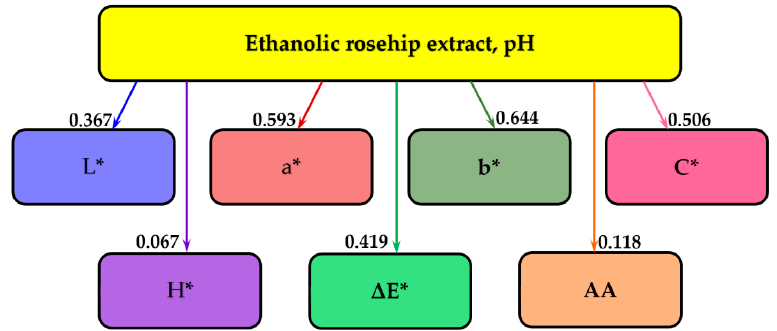
Figure 4. The influence of the pH on the CIELab color parameters and antioxidant parameters of rose hip extract. L*—luminosity; a*—red / green component; b*—yellow / blue component; C*—chromaticity; H*—hue angle; ∆ E*—overall di ff erence of color; AA—antioxidant activity.